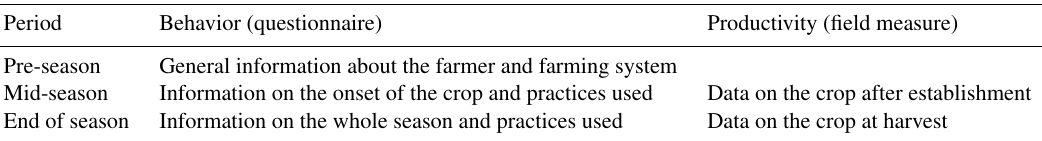
Table 1. Survey tools. Period Behavior (questionnaire) General information about the farmer and farming system Information on the onset of the crop and practices used Data on the crop after establishment Information on the whole season and practices used Data on the crop at